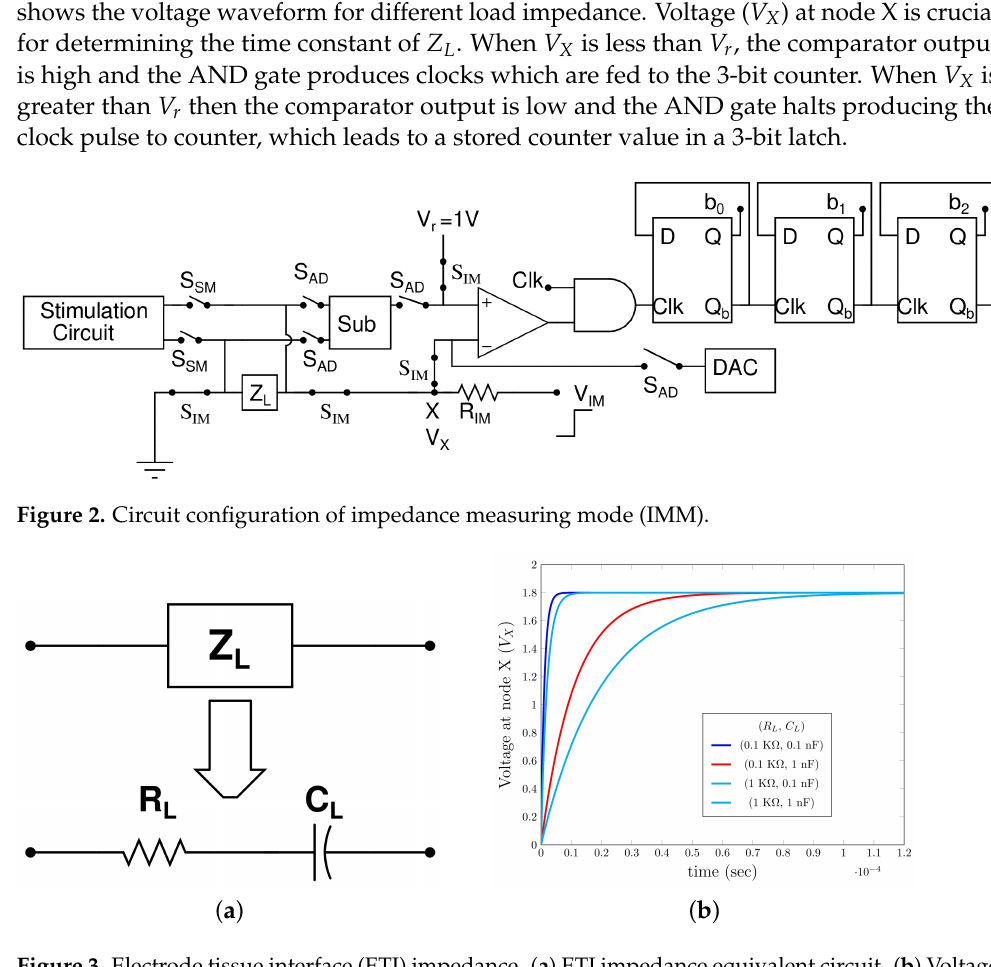
Figure 3. Electrode tissue interface (ETI) impedance. ( a ) ETI impedance equivalent circuit. ( b ) Voltage response at X node for different load